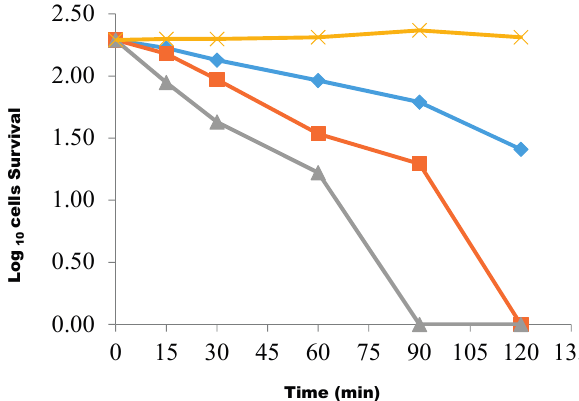
Figure 1. The extent and the rate of killing of test bacterial cells by the butanol fraction at concentrations of 1× MIC ( ◊ ), 2× MIC ( ■ ), 3× MIC ( ▲ ) and the control (X). Each point represents the log 10 of the mean survival of bacterial cells at a particular time interval in the presence of the fraction.